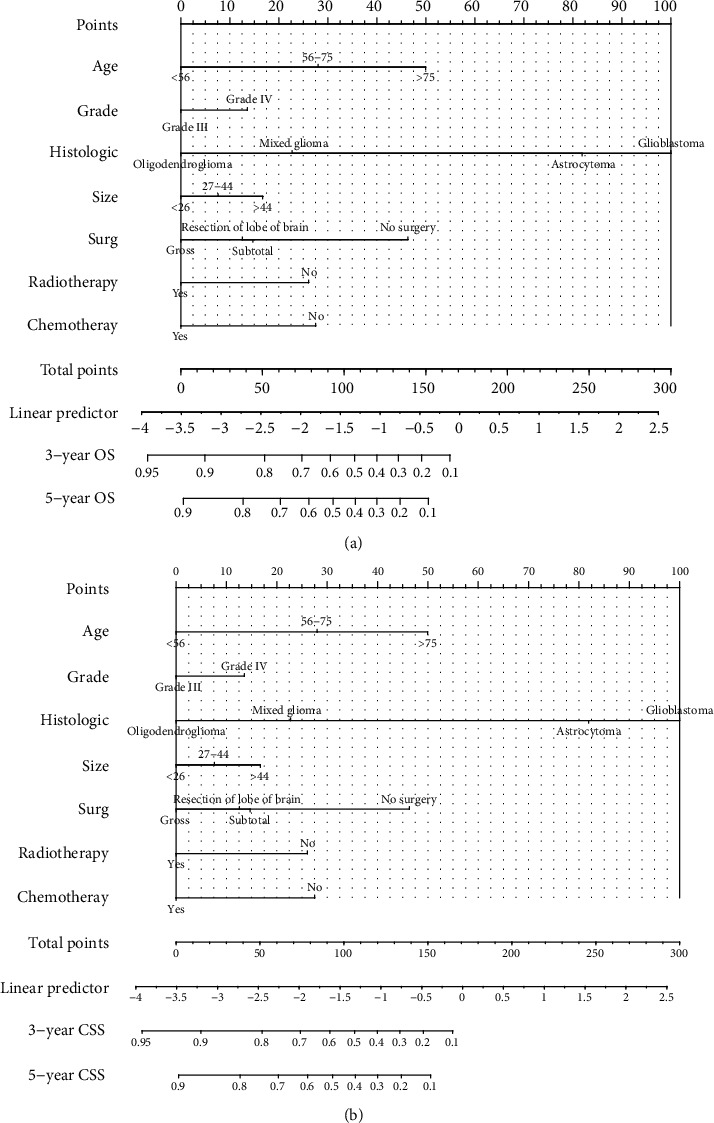
The nomograms of the prediction of 3- and 5-year OS and CSS in adult glioma patients based on the training set.